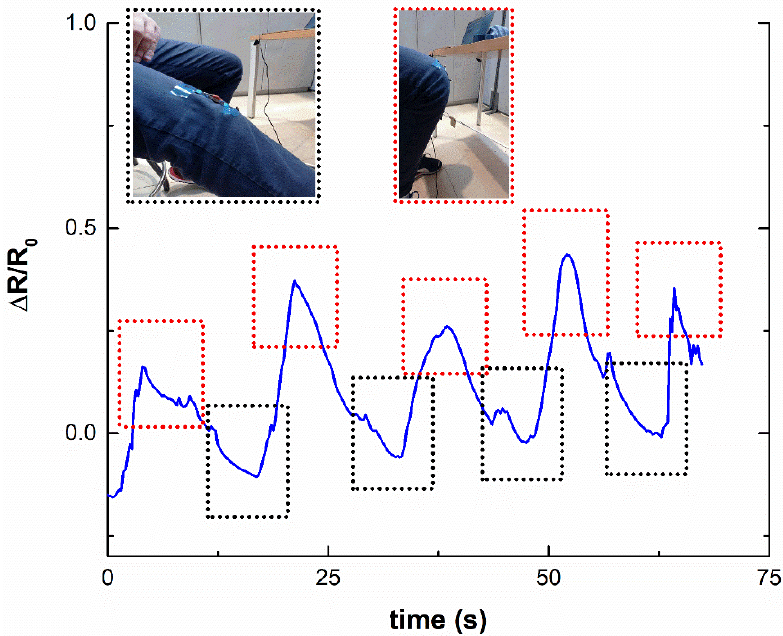
Figure 8. Electromechanical response of knee motion under consecutive bending cycles.